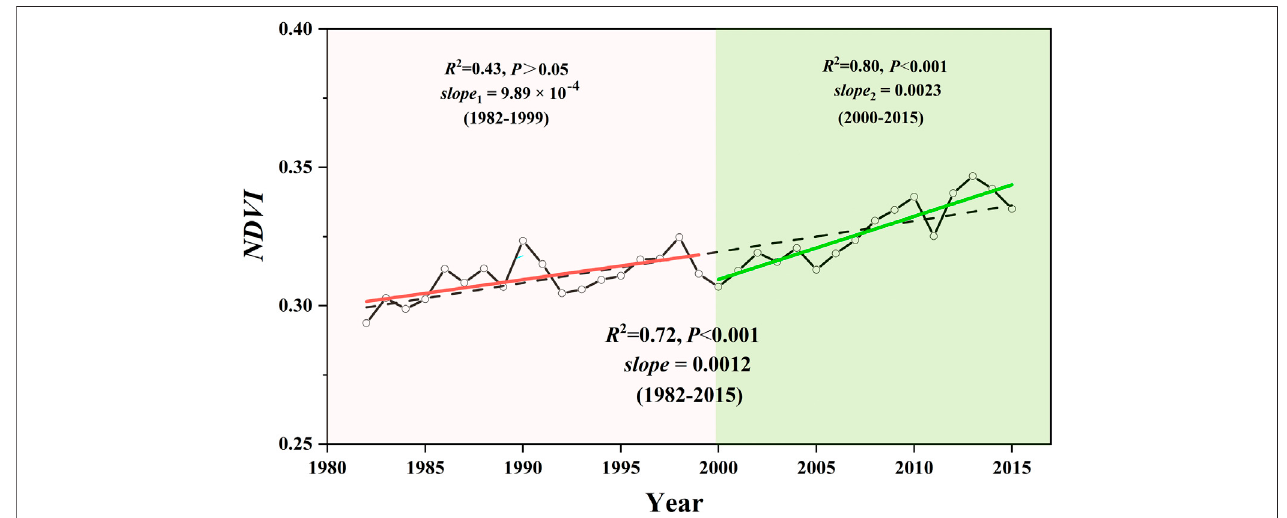
FIGURE 9 | Trends of annual NDVI before and after the implementation of the Grain for Green Program launched in 1999.